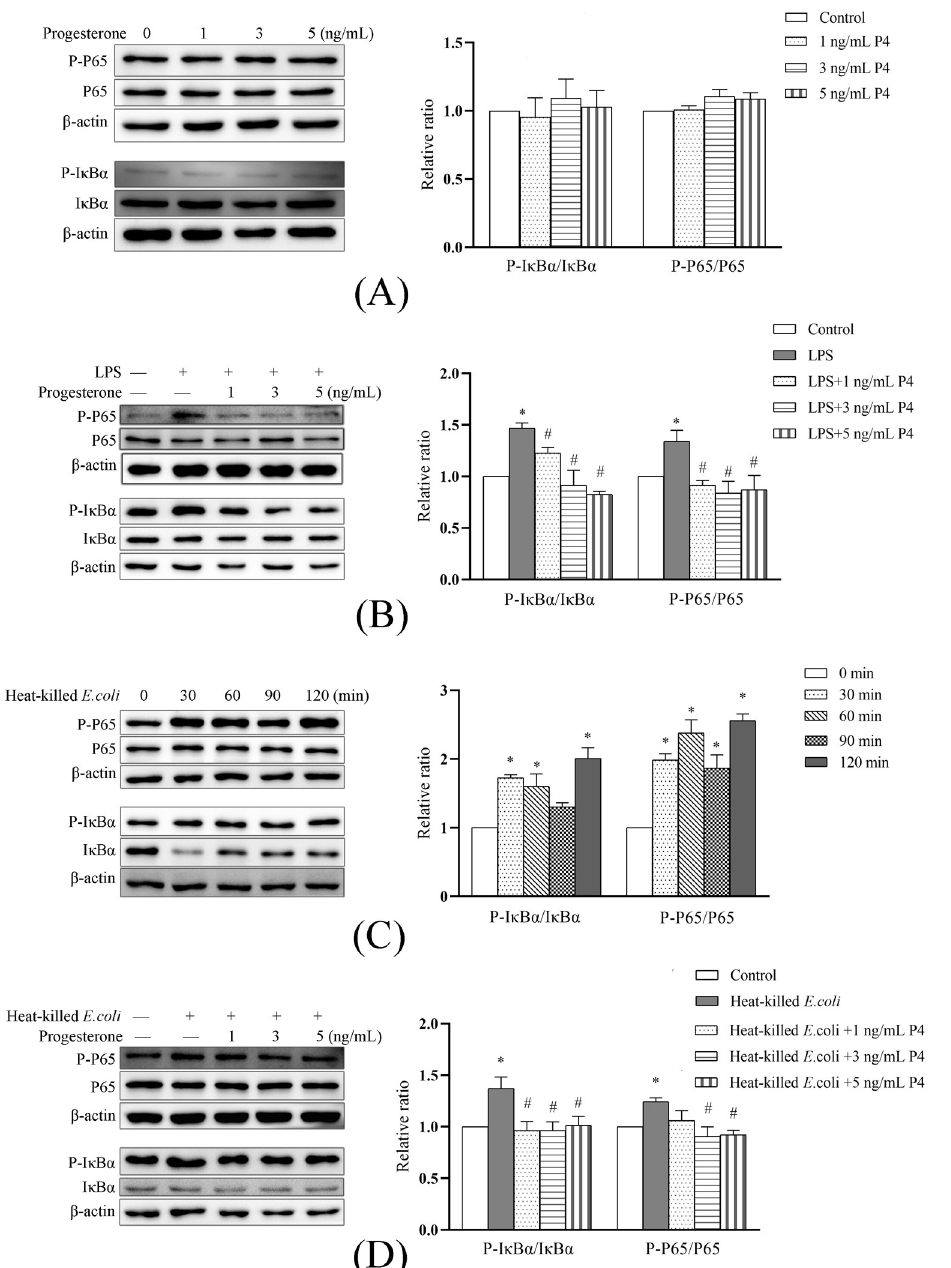
Fig 3. Progesterone inhibited phosphorylations of I κ B α and P65 in primary bovine endometrial stromal cells in response to lipopolysaccharide or heat-killed E . coli stimulation. The protein level of I κ B α , P-I κ B α , P65, and P-P65 was determined using Western blot. The protein blots were quantified by Quantity One software. A. Unstimulated cells were treated with 1, 3, and 5 ng/mL progesterone for 30 min. B. The cells were cotreated with 1 μ g/mL lipopolysaccharide and progesterone (1, 3, or 5 ng/mL) for 45 min. This time point was based on the results of our previous study. C. Time-course changes in key protein phosphorylation of NF- κ B pathway in cells challenged with 1 × 10 8 CFU/mL heat-killed E . coli for 30, 60, 90, and 120 min. D. The cells were cotreated with heat-killed E . coli and progesterone for 120 min. LPS, lipopolysaccharide. P4, progesterone. All data were presented as means ± SEM (n � 3). � P < 0.05, difference compared with the control; # P < 0.05, difference compared with the LPS group (B) or the heat- killed E . coli group (D).